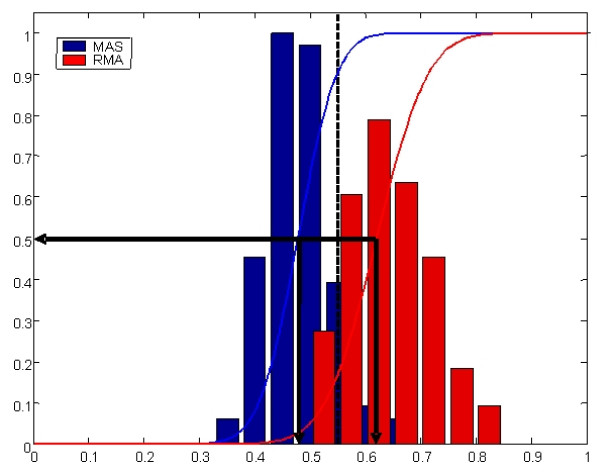
Stability normalization of Jaccard index. Illustration of stability normalization for the Jaccard index of a particular k-means clustering (k = 12), obtained on MAS- and RMA-pre-processed versions of the AML dataset (correlation distance, 3000 probesets). The dotted line corresponds to the Jaccard index between these clusterings (0.55). For both MAS and RMA, the CDF can be used to arrive at a stability normalized Jaccard index; in this case 0.90 and 0.16. The arrows indicate the Jaccard indices for which the normalised Jaccard index JSN = 0.5. The interpretation is that for MAS, the comparison to RMA falls well within what can be expected, for RMA less so.